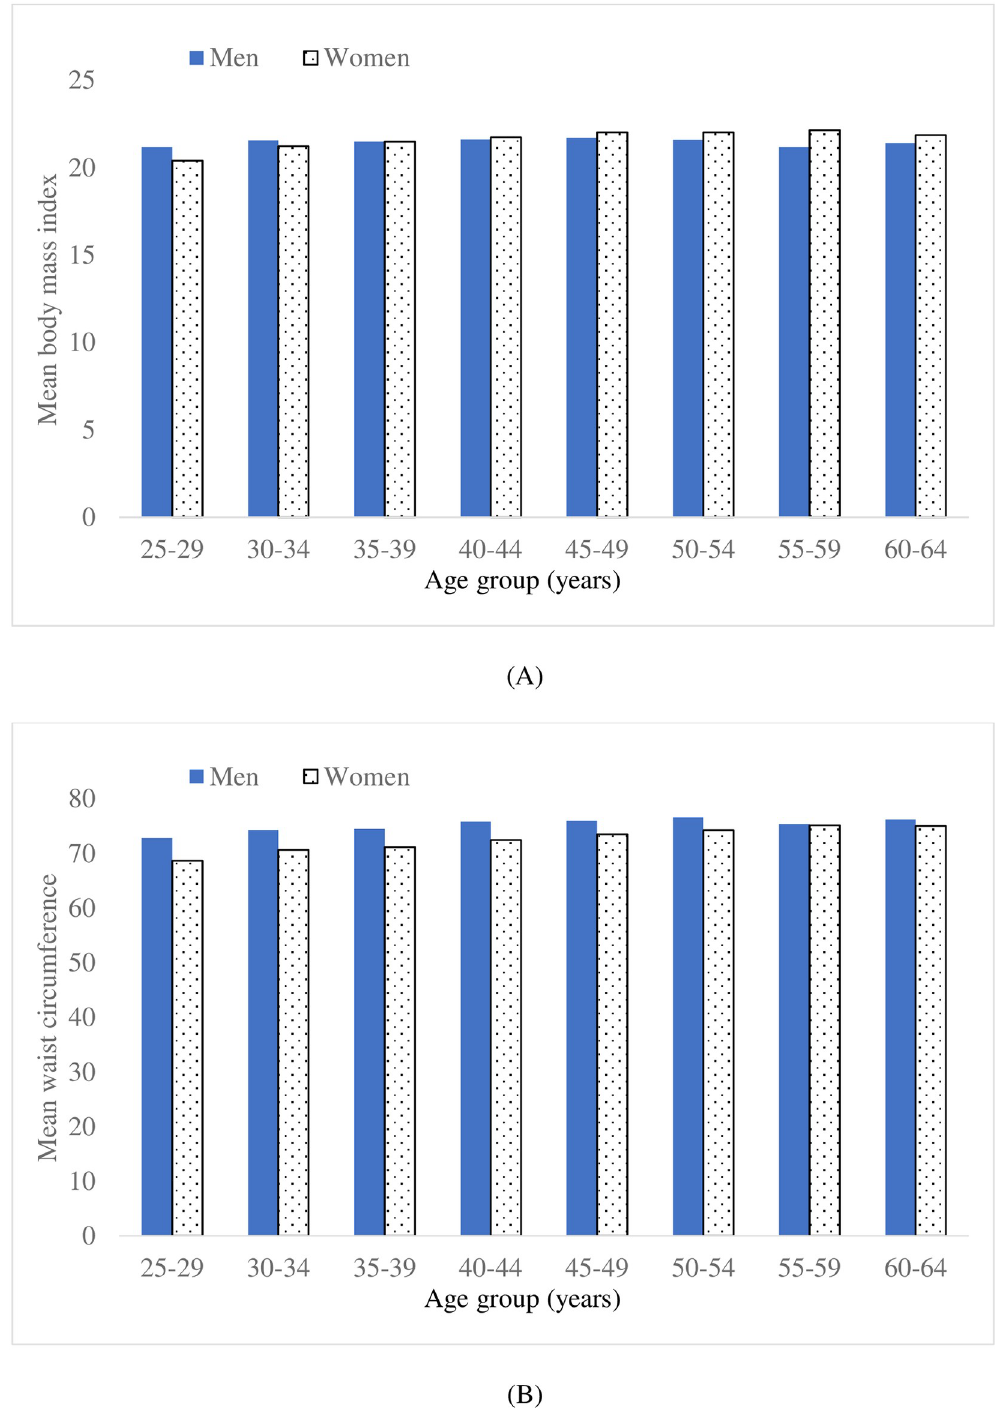
Fig 2. Means of body mass index (A) and waist circumference (B) by age group and sex.